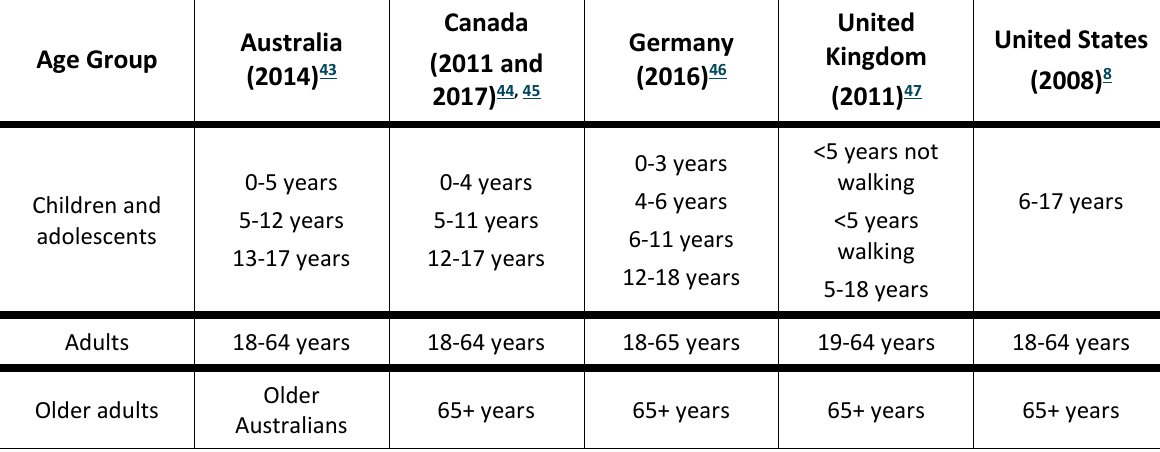
Table C-2. Age Groups in National Physical Activity Guidelines or Recommendations from Five Developed Nations Age